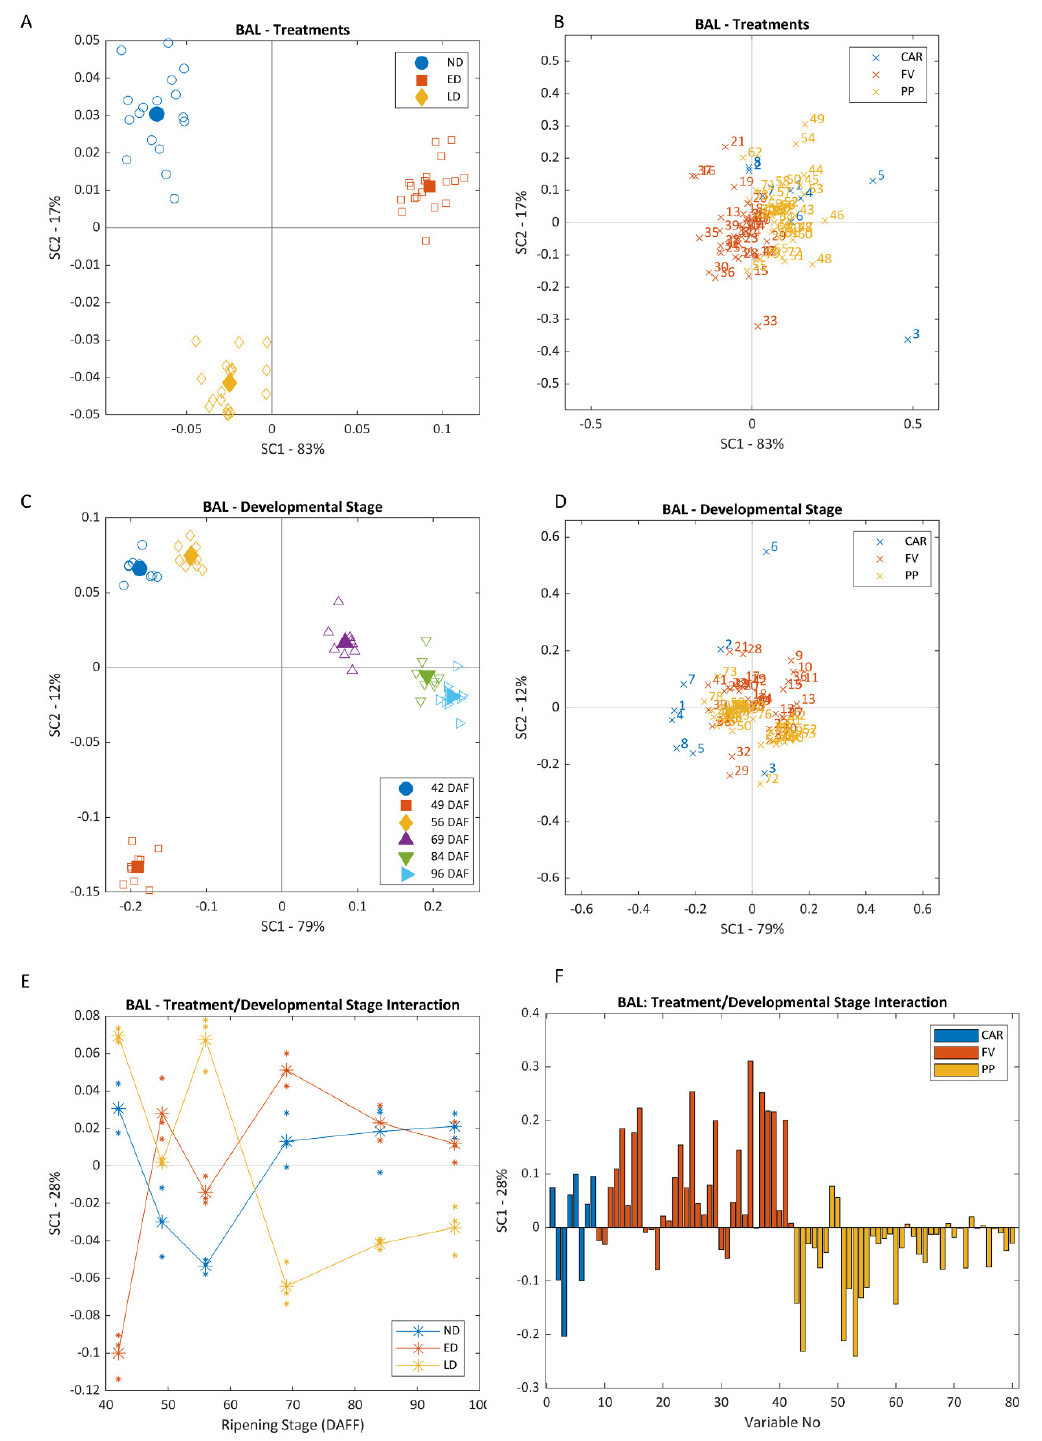
Figure 1. Scores ( A , C ) and loadings ( B , D ) ASCA plots for the first and second SC, and longitudinal scores ( E ) and loadings ( F ) plots for SC1, for BAL vineyard. Plots ( A , B ) correspond to factor Treatments, ( C , D ) to factor Developmental Stage, and ( E , F ) to the model’s interaction term. A list of variables used in loadings plots ( B , D , F ) can be found in Supplementary Table S5. SC stands for simultaneous component; ND, no defoliation; ED, early defoliation; LD, late defoliation; CAR, carotenoids; FV, free volatiles; PP, polyphenols; DAF, days after flowering. Filled symbols indicate group centroids ( A , C ).